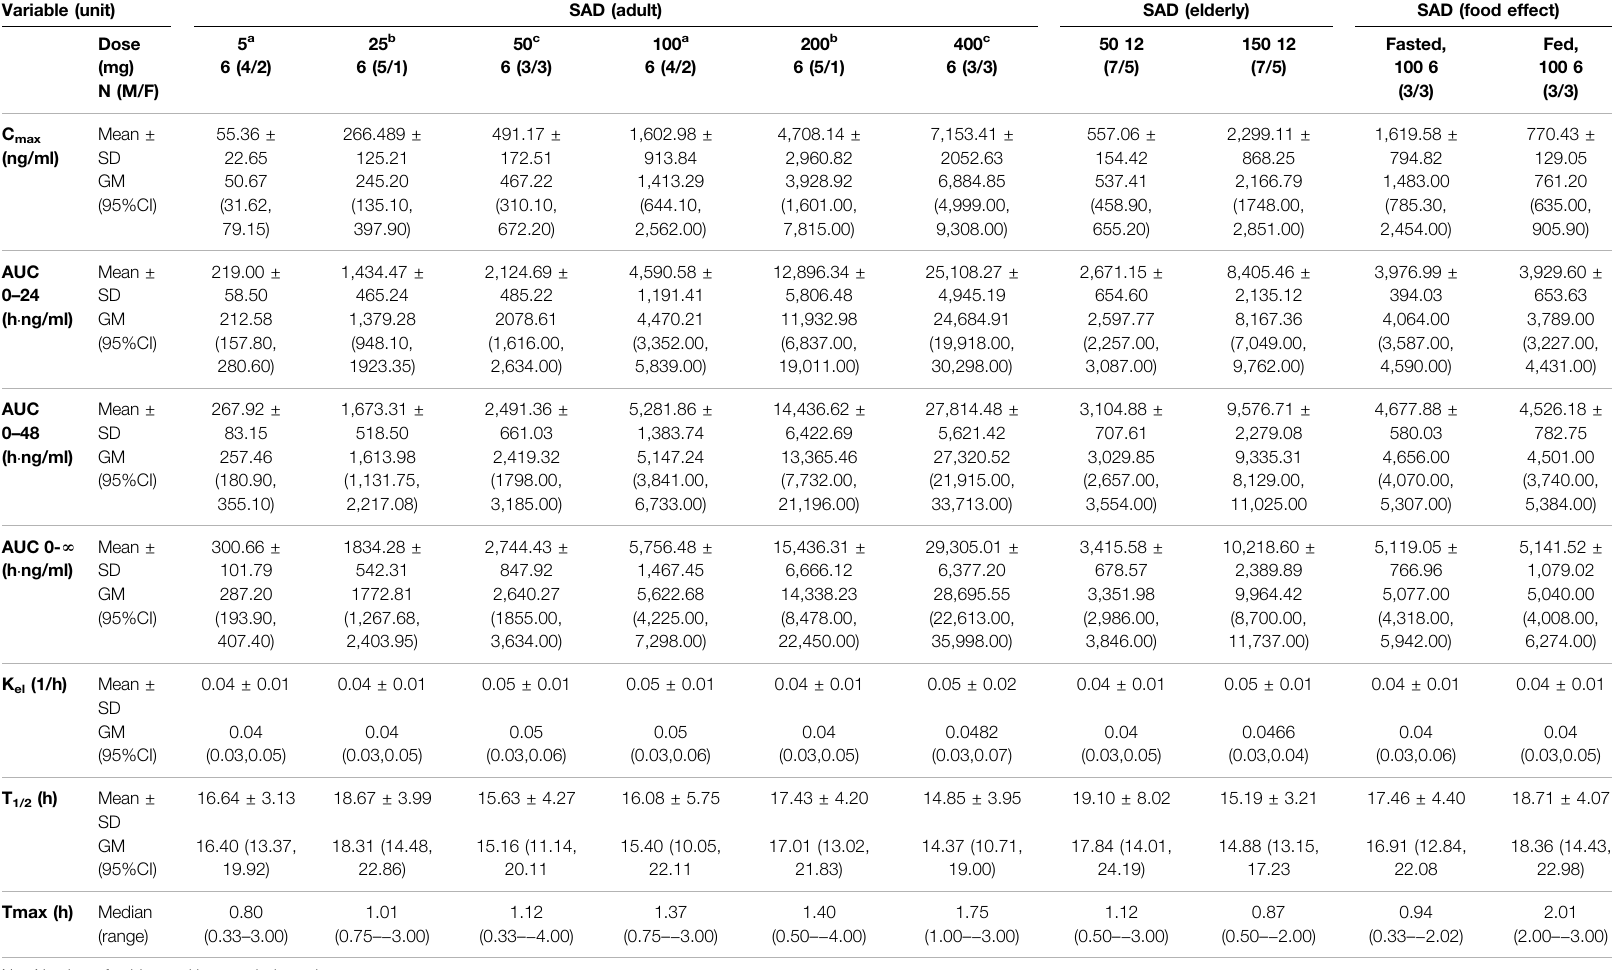
TABLE 4 | Summary of PK parameters of single dose study